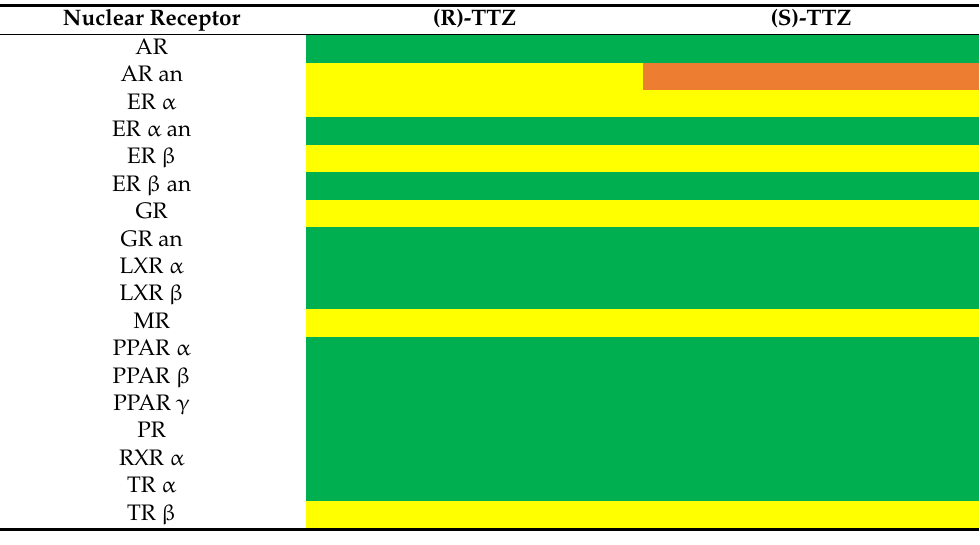
Table 6. Predictions regarding the inhibition of the nuclear receptors by the triticonazole